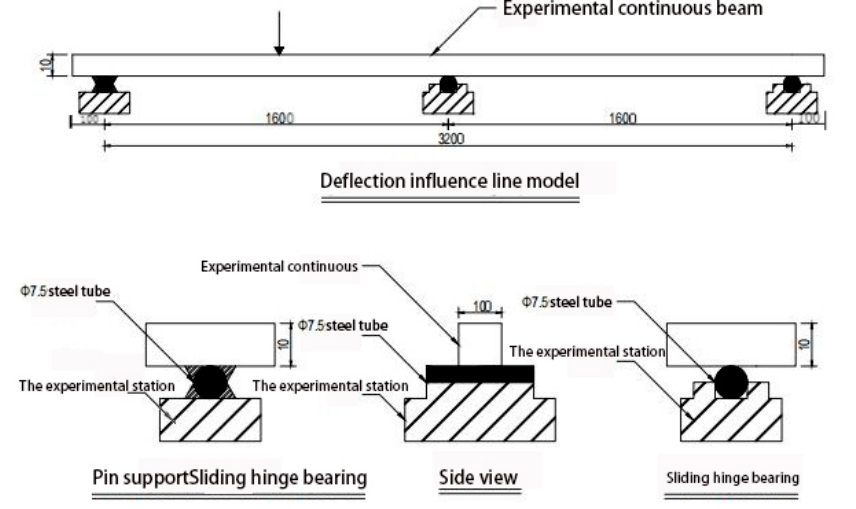
Figure 25. The test models. Figure 25. The test